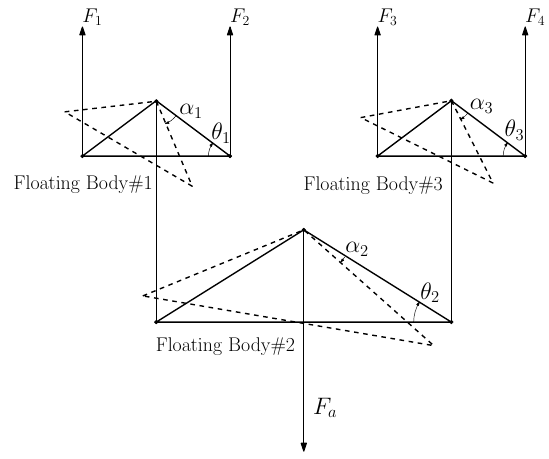
Figure 7. Schematic illustration of the mechanism allowing under- actuation between the